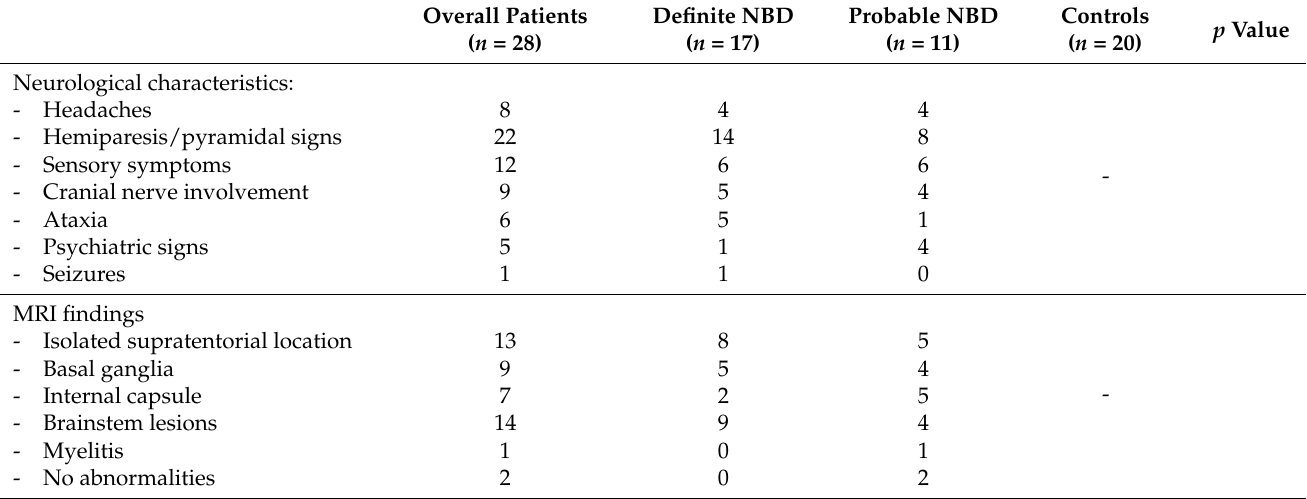
Table 2. Neurological characteristics, MRI findings, and CSF data of subjects included in the